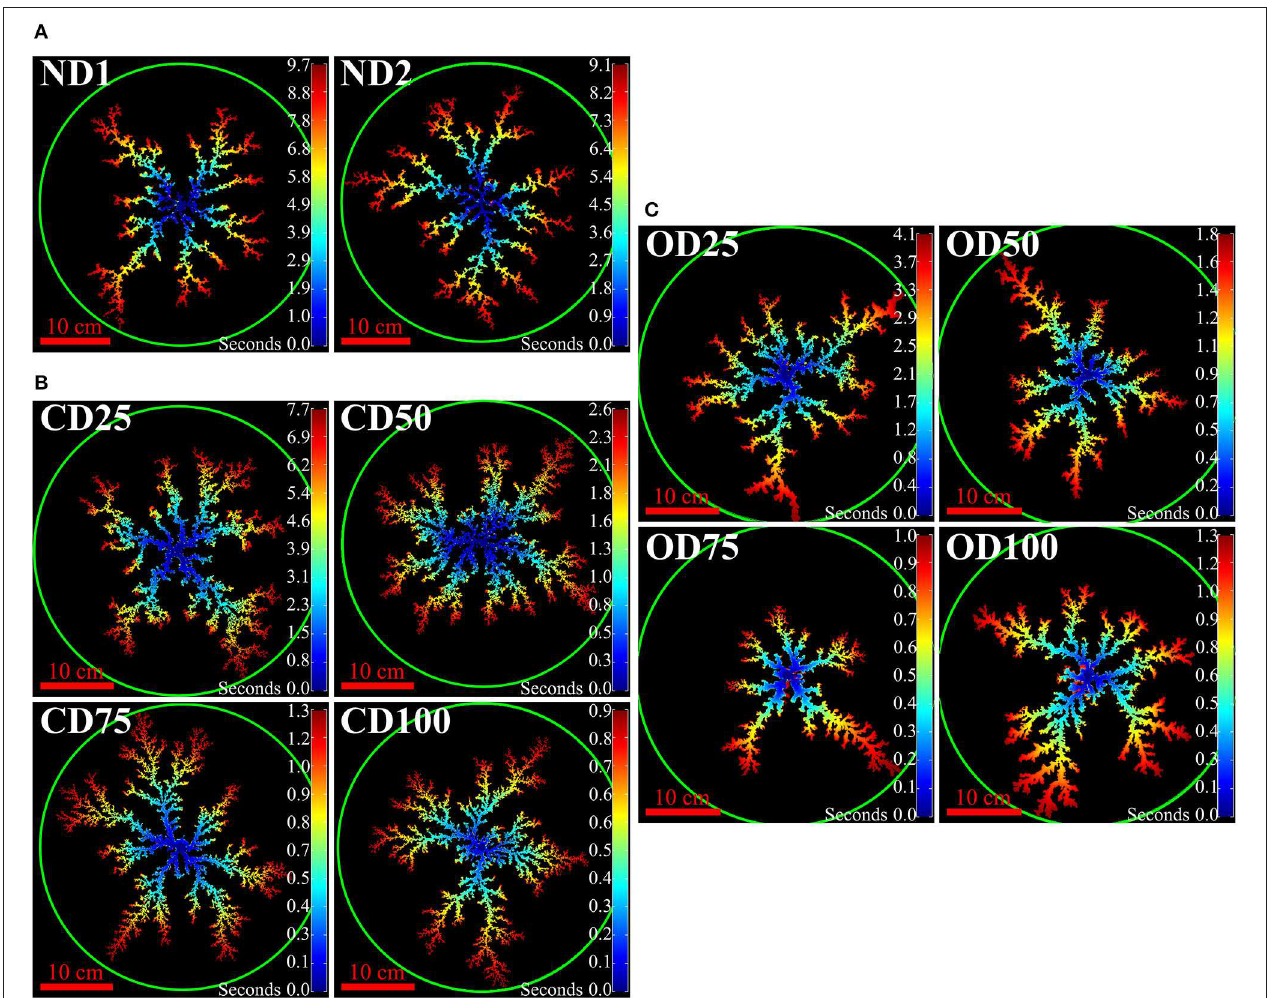
FIGURE 3 | Breakthrough patterns for the non-deformable experiments (A), confined deformable experiments (B), and open deformable experiments (C). Both ND experiments have an injection pressure of 25 hPa, while for the CD and OD experiments the number in the experiment name (top left corners) gives the injection pressure in hPa. The color code indicates the time of air invasion in seconds after start, where blue is at the start and dark red is at breakthrough. The green circles indicate the cell